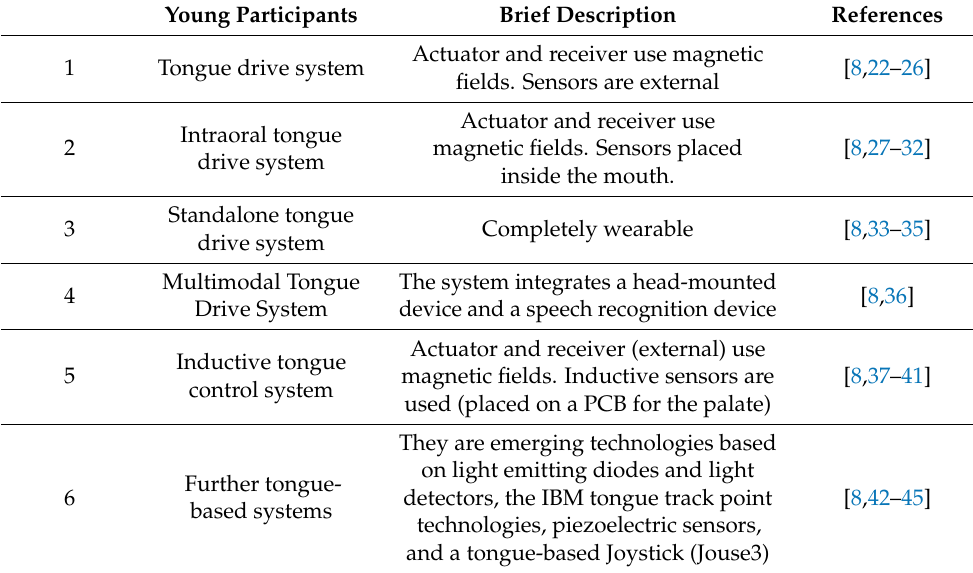
Table 3. Categorization of the tongue-based